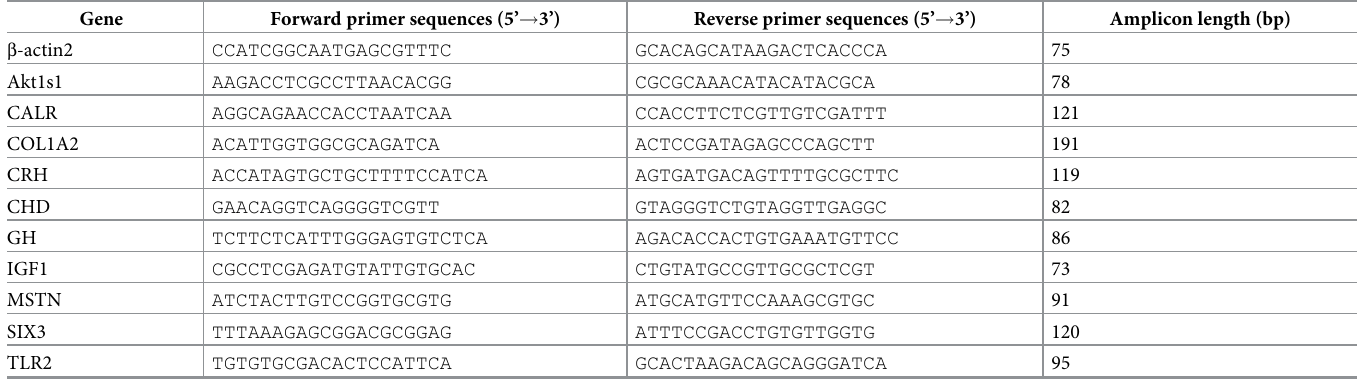
Table 2. Data of applied primers.